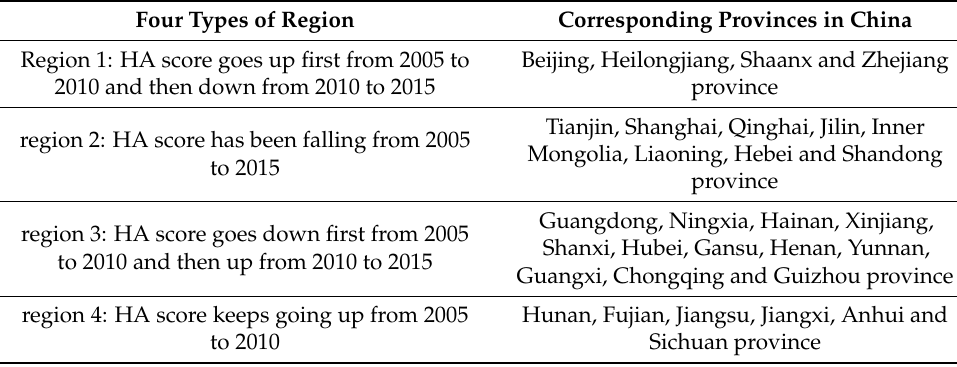
Table 7. Four regional divisions according to the cross-section trend in 2005, 2010 and 2015. Four Types of Region